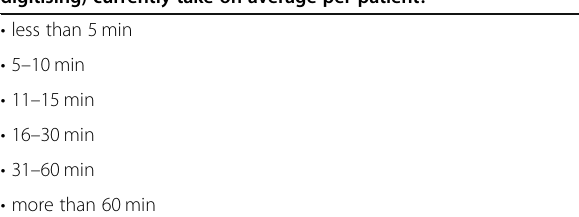
Table 2 This question is included in the questionnaire for “ collection and documentation of consents